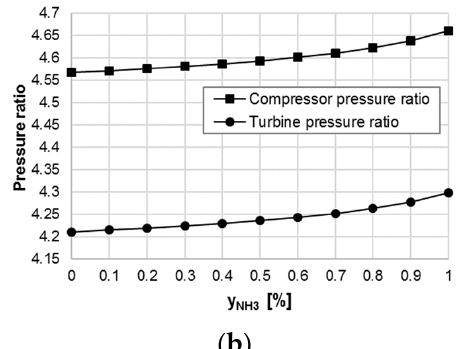
Figure 6. Effects of increasing ammonia blending ratio (y NH3 ) on: ( a ) mass flow rate of air, fuel, and flue gas; ( b ) compressor pressure ratio and turbine expansion ratio.